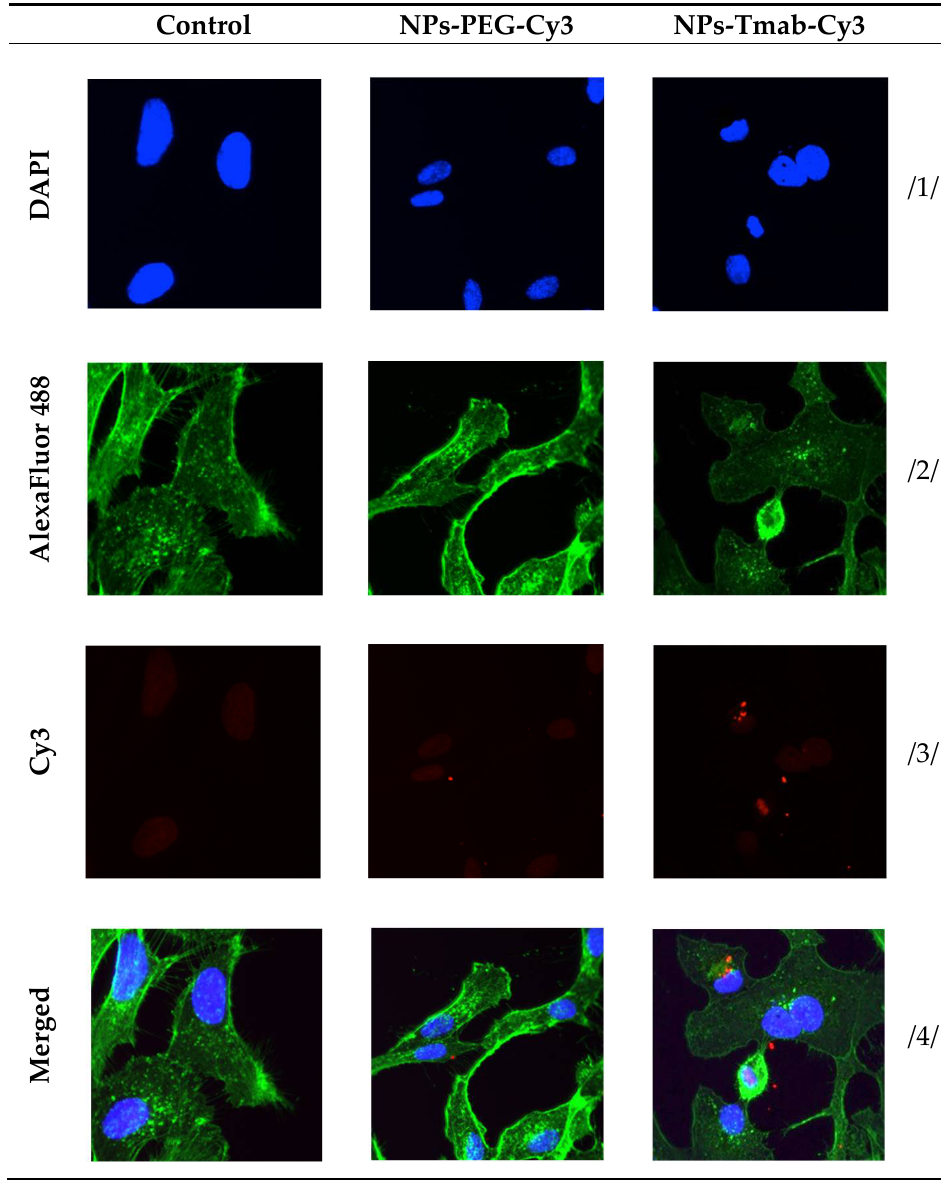
Figure 12. Internalization of the NPs-PEG-Cy3 and NPs-Tmab-Cy3 bioconjugates by SKOV-3 cells determined by confocal microscopy. Cells treated and untreated (control) are shown as a reference. Fluorescence signals present: /1/ blue, nuclei localization; /2/ green, cytoskeleton; /3/ red, Cy3 modified NPs; /4/ merged photos. Magnification 20× with Zeiss LSM 880 confocal laser scanning microscope (Zeiss, Jena, Germany) with ZEN 2 black edition software.